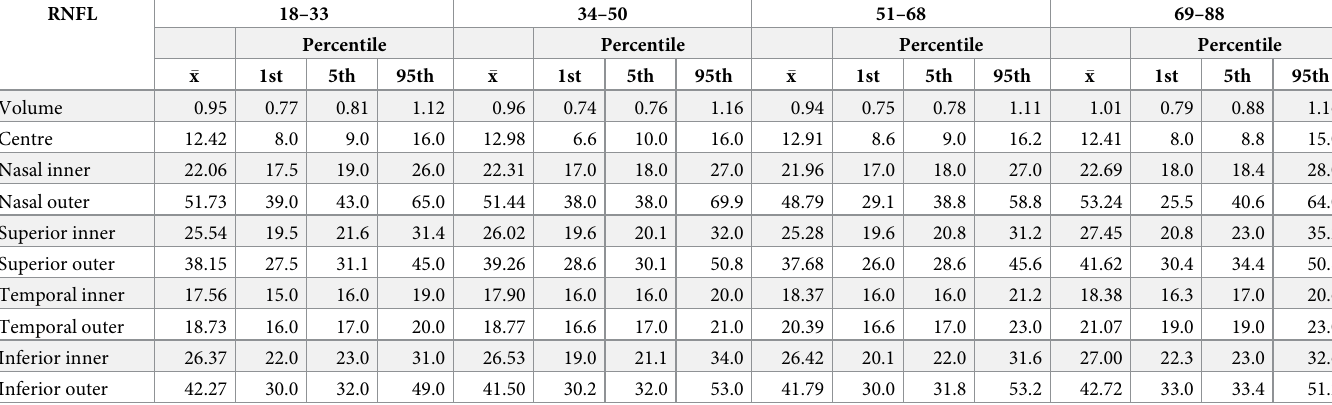
Table 5. Macular retinal nerve fibre layer thickness distribution by age group, showing mean, first, fifth and 95th percentile values for each